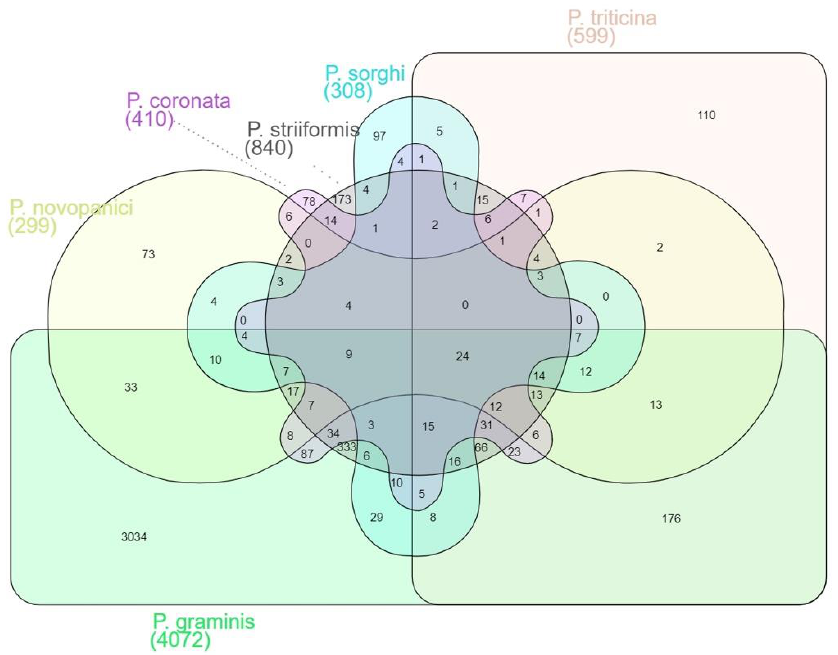
Figure 4. Comparative mapping of secretory and effector proteins from Puccinia spp. Effector protein comparison among Puccinia genomes. Venn diagram represents effector proteins from different Puccinia genomes. Total secretory proteins of the genomes are processed through EffectorP and the predicted effector proteins. Homology of effector proteins was identified using BLASTp. The total numbers shared between genomes are also represented in the Venn diagram. Table 3. Effector protein classes enriched in Puccinia